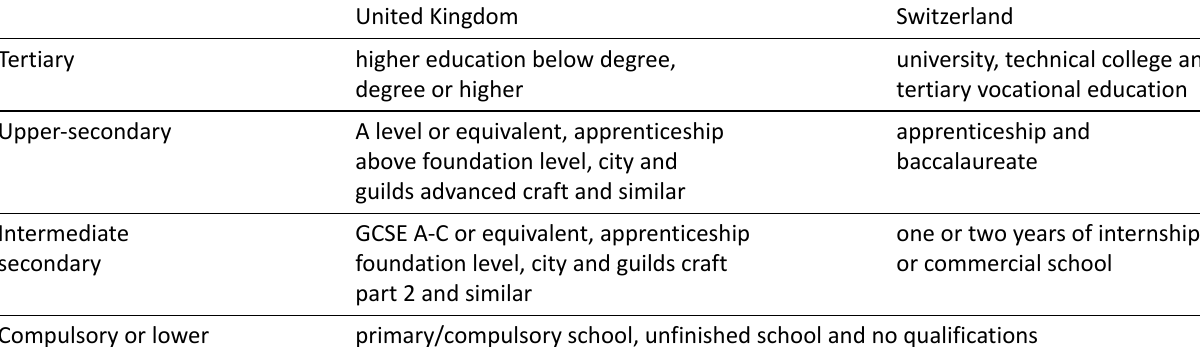
Table A1. Definition of educational categories, United Kingdom and Switzerland.